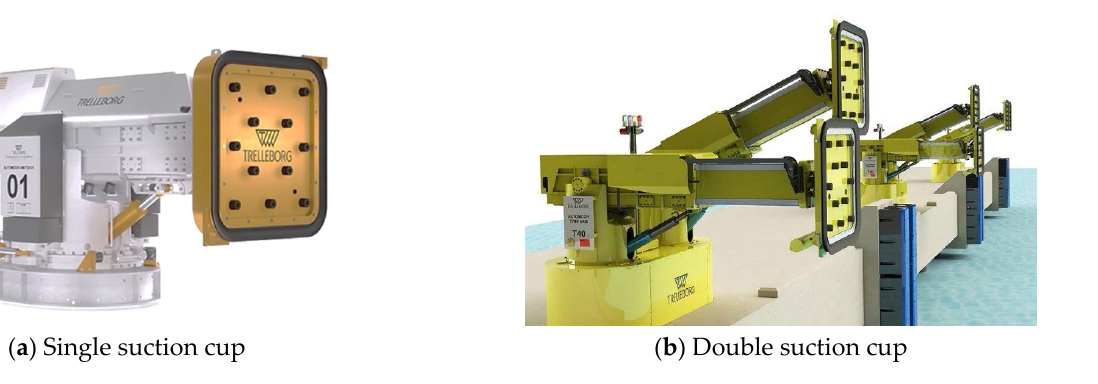
Figure 5. MoorMaster TM vacuum mooring systems type showing ( a ) MM200C, ( b ) MM200E, ( c ) MM200LS, ( d ) MM400, ( e ) MM400A, ( f ) MM400E, ( g ) MM I-400, ( h ) MM600, ( i ) MM800 (adapted with permission from Ref. [28]. Copyright 2014 Cavotec).